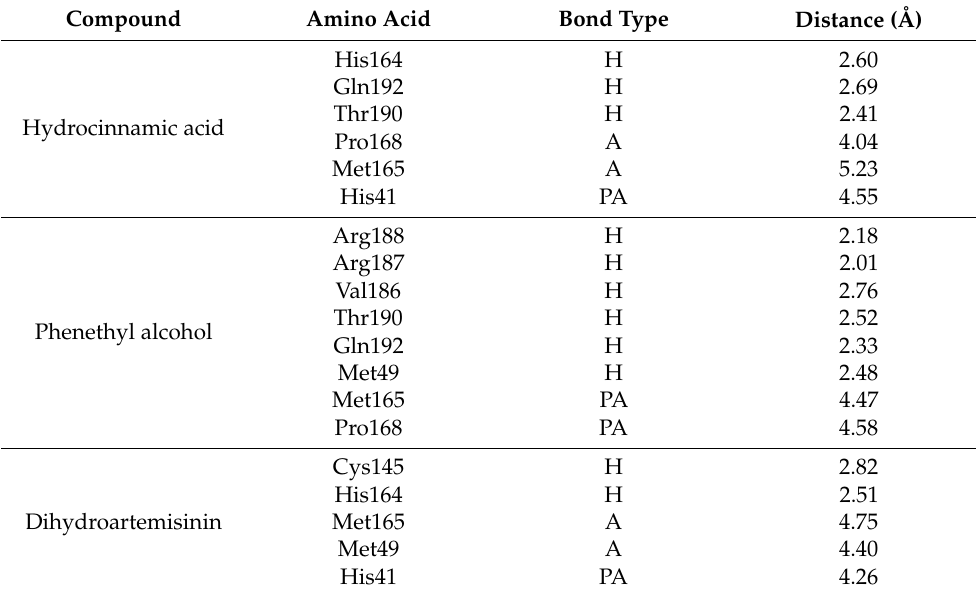
Table 2. The non-bonded interaction analysis from the top screened ligand